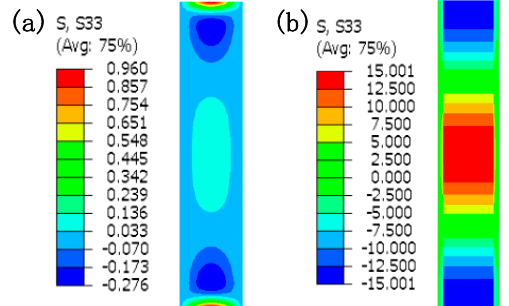
Figure 4. Longitudinal stress at a stable time calculated by different methods under a small aspect ratio of 1:5: ( a ) finite element method (FEM); and ( b ) FE-IE coupling method.